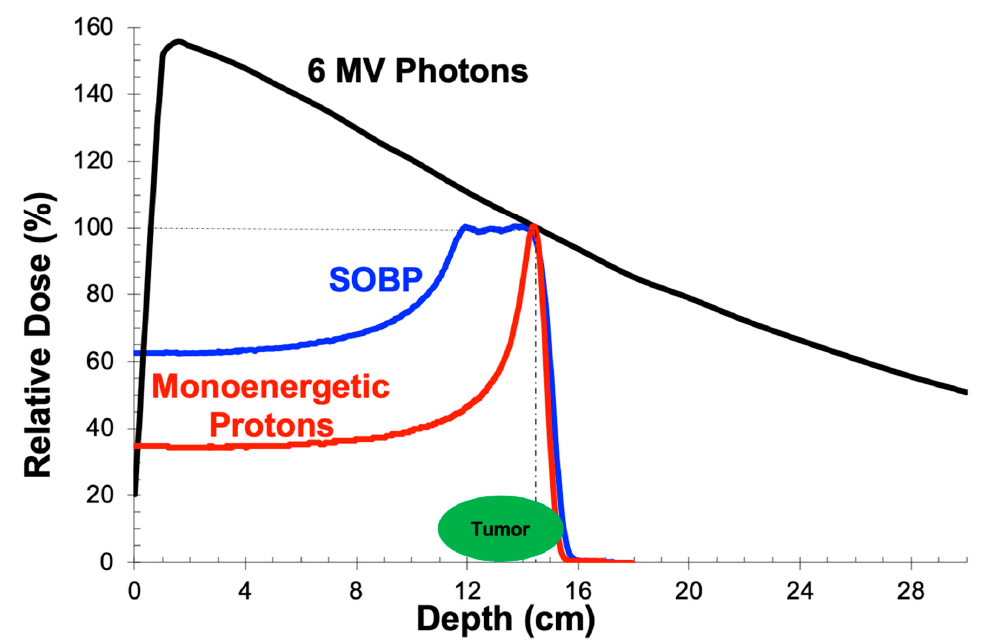
Figure 1. Single beam dose profiles for photons and protons. D max , the peak of the 6 MV photon curve (black), occurs at a depth of about 1.5 cm for a 10 × 10 cm field. The characteristic Bragg peak of a monoenergetic proton beam (red) is centered at a depth of 14.5 cm. The distal edge, to the right of the vertical dashed line, is an area of great interest when limiting dose to normal tissues immediately beyond the tumor. The spread-out Bragg peak (SOBP; blue) represents a summation of Bragg peaks from multiple protons with varied energies. This allows tumors (green) to be covered adequately by depositing therapeutic doses of radiation over a longer path.